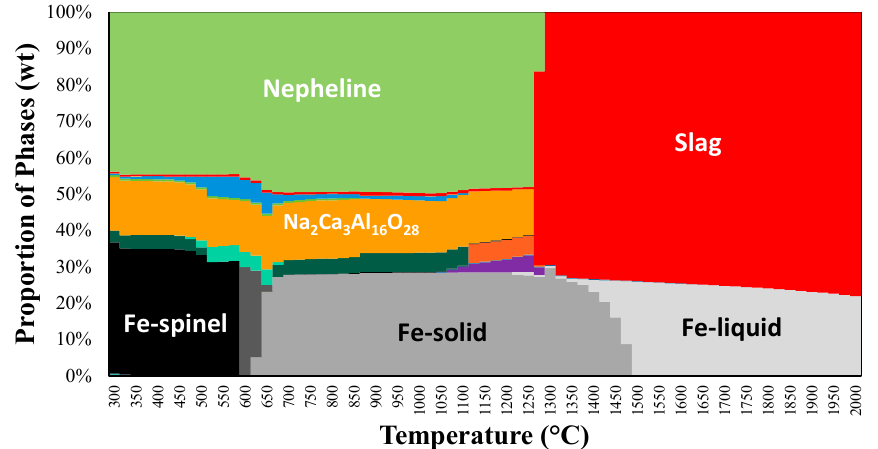
Figure 2. Type and proportion of phases as a function of temperature from reduction at 7% carbon + 5% LLDPE addition based on FactSage calculation.